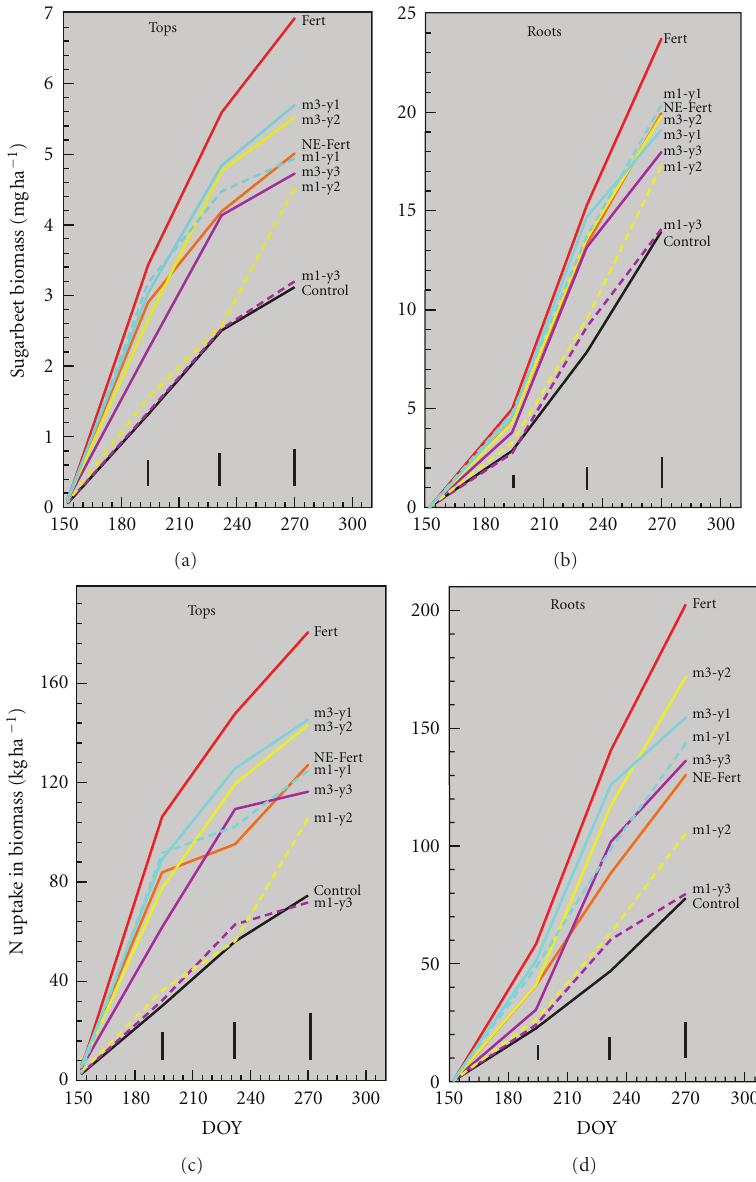
Figure 2: The e ff ect of treatments on biomass accumulation in sugarbeet tops, that is, aboveground tissue (a) and root (b) components, and on N uptake in sugarbeet tops (c) and roots (d) in 2007. (Measured on dates (DOY) 1 June (152), 13 July (194), 20 Aug. (232), and 27 Sep. (270). Bar length represents the mean standard error ( n = 4) for the 9 treatments at the given measurement date.